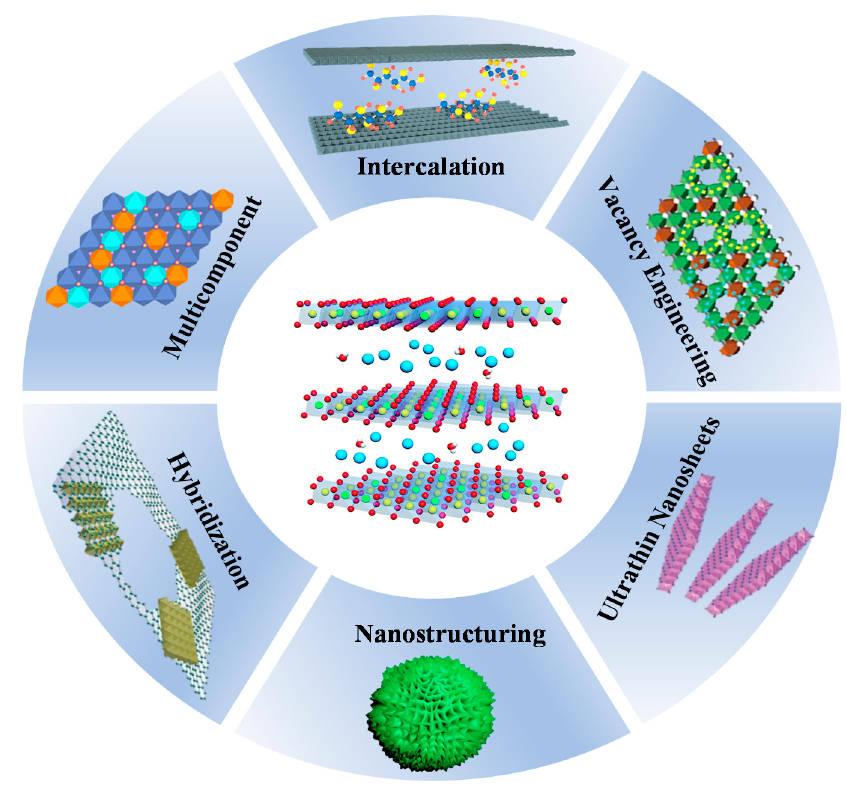
Figure 1. The design of the different modification strategies for LDHs